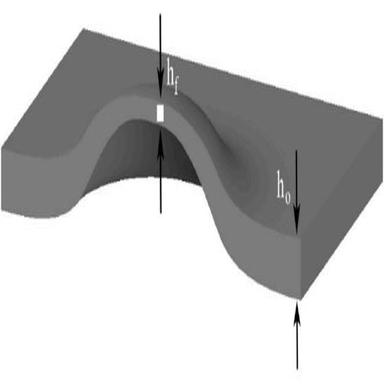
Schematic presentation of a cross-sectioned sample. The area marked by white square refers to the region selected for EBSD and TEM characterization.